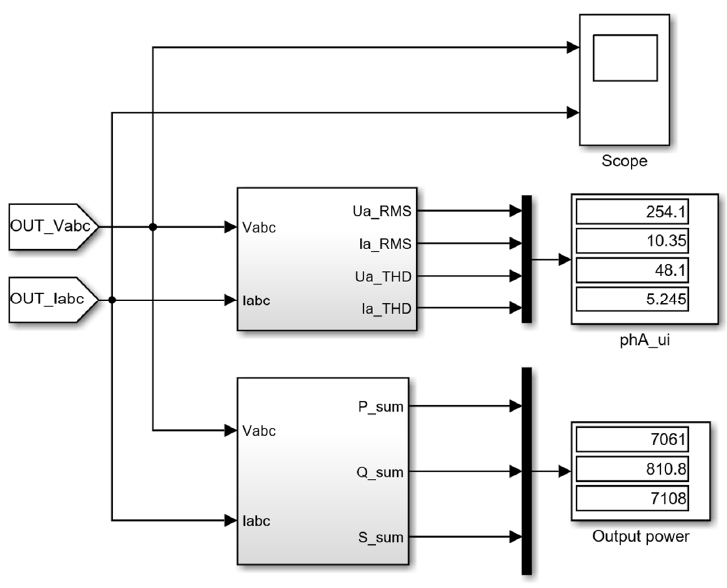
Figure 5. Simulink-model of the measurement system unit.